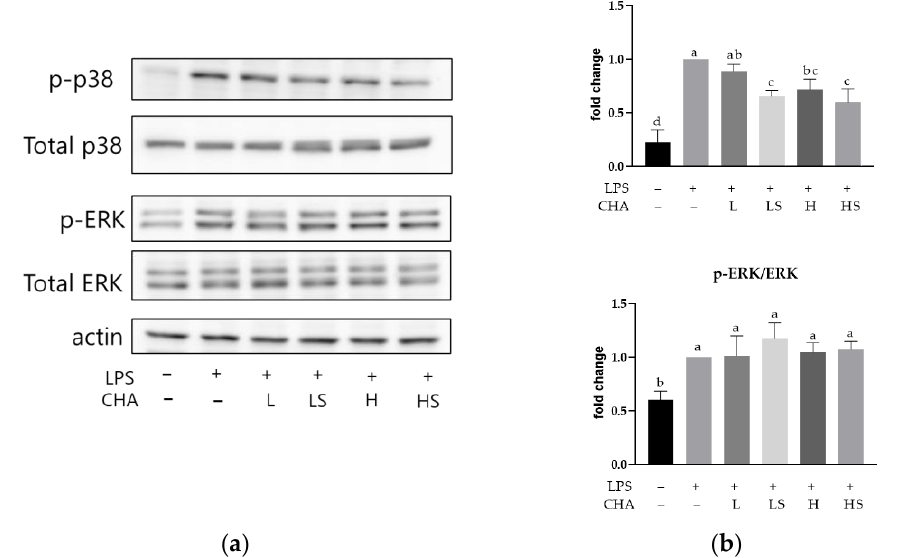
Figure 5. Effect of different delivery models on the phosphorylation levels of MAPK. Cells were treated with LPS (100 ng/mL) and CHA for 2 h. ( a ) Representative images of phosphorylated p38, total p38, phosphorylated ERK, and total ERK. ( b ) Quantification of the proportion of phosphorylated p38 and total p38 and phosphorylated ERK and total ERK. Bars without a common letter indicate significant differences ( p < 0.05). CHA: chlorogenic acid; LPS: lipopolysaccharide; ERK: extracellular signal-regulated kinase; L: low dose administered via pipette; LS: low dose administered via syringe pump; H: high dose administered via pipette; HS: high dose administered via syringe pump. NF- κ B is also activated by a variety of stimuli and regulates the expression of a